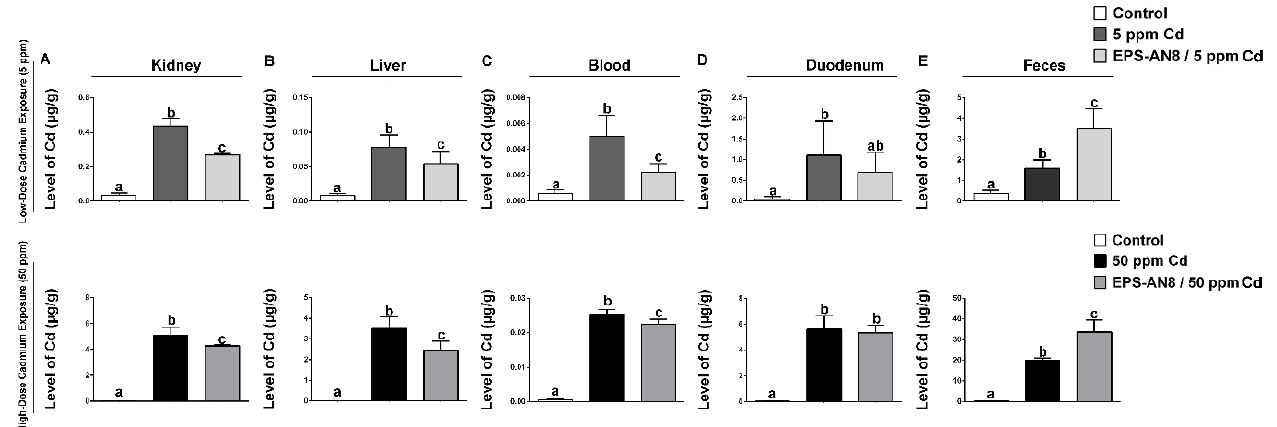
Figure 1. Effects of EPS-AN8 on Cd deposition in rats exposed to lower (5 ppm) and higher (50 ppm) dose of Cd in kidney ( A ), liver ( B ), blood ( C ), duodenum ( D ), and feces ( E ). Results are presented as mean ± standard deviation (SD). Values that do not share a common letter are significantly different ( p < 0.05).